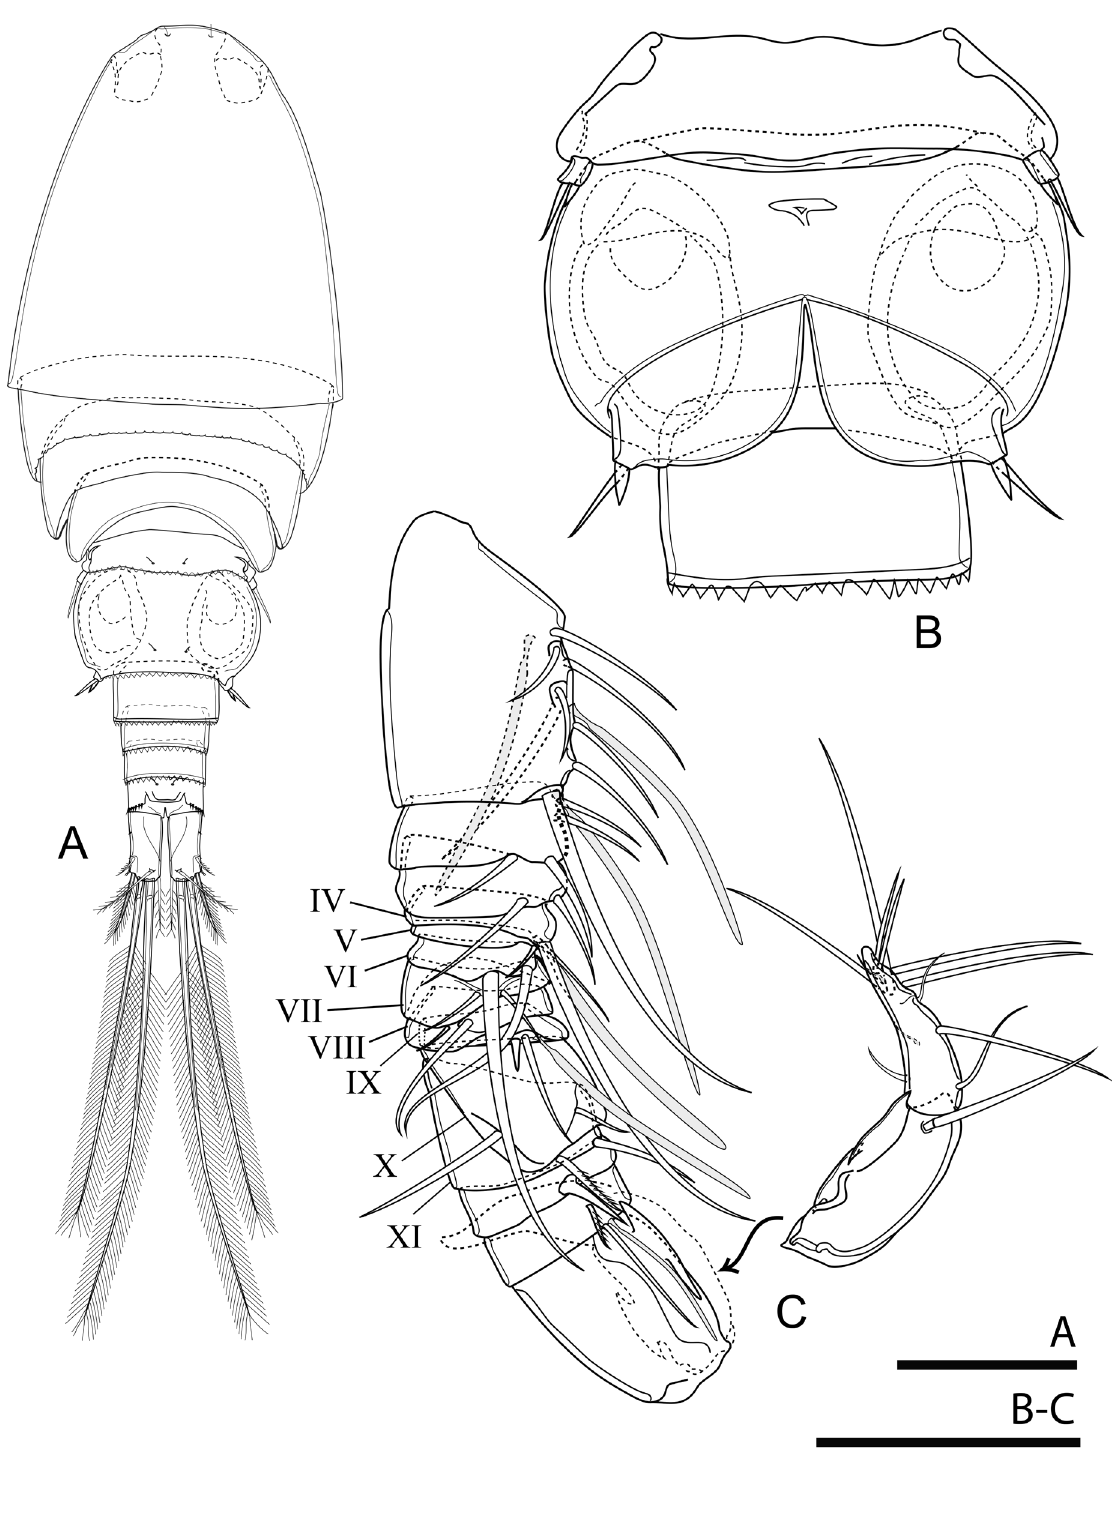
Fig. 8. Metacyclops sakaeratensis sp. nov., paratype, ♂ (A; ZMB 34230 slide No. 5123) and allotype, ♂ (B−C; ZMB 34230 slide No. 5121). A . Habitus, dorsal view. B . Genital and first abdominal somites, ventral view. C . Antennule (Roman numerals indicate segment of antennule). Scale bars: A = 100 μm; B−C = 50